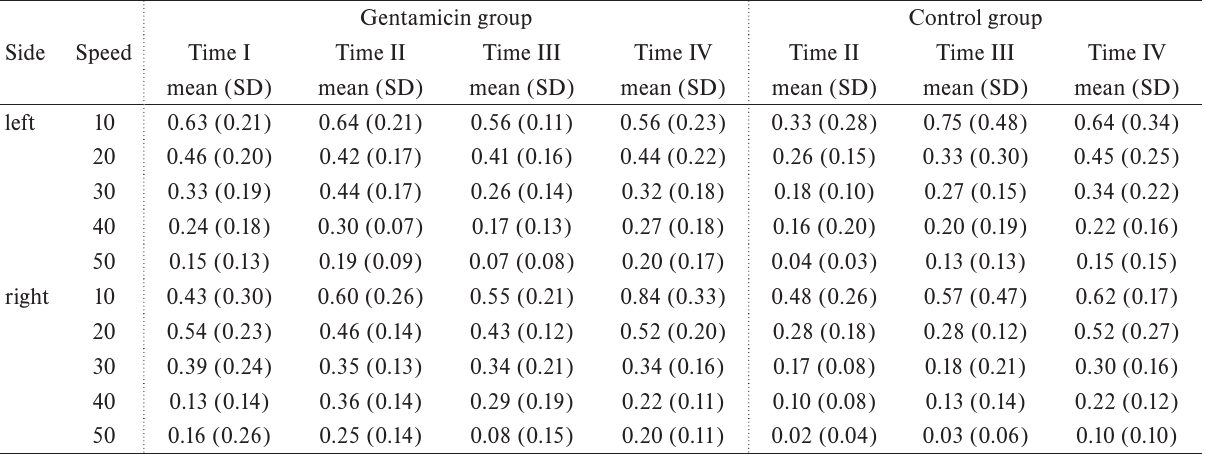
Table 4. Results - optokinetic